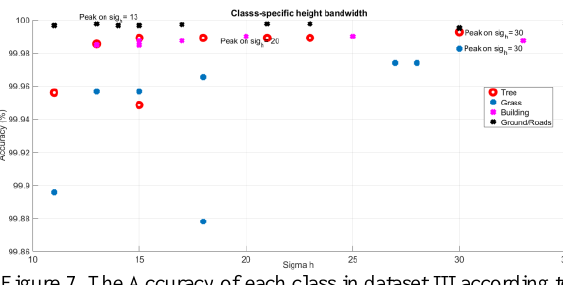
Figure 7. The Accuracy of each class in dataset III according to the height bandwidth.